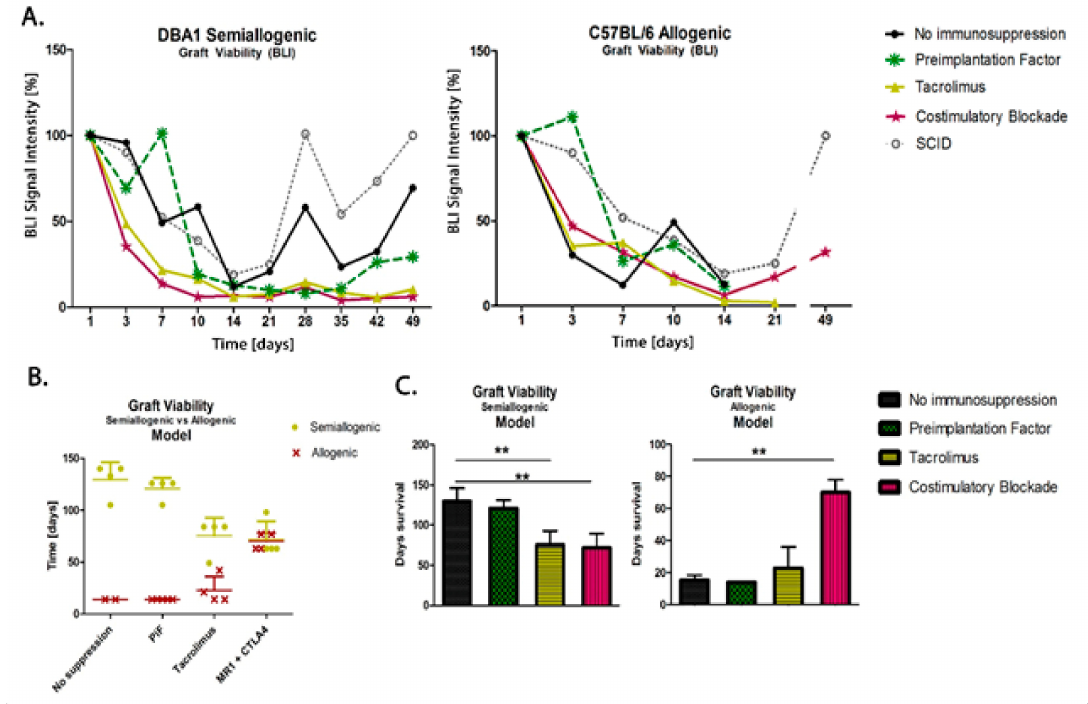
Figure 7. Comparison of graft survival in semiallogenic DBA1 and allogenic C57BL/6 mouse models: ( A ) Graphic presentation of GRP graft viability (presented as the proportion out of initial BLI as 100% of intensity signal) transplanted into healthy models in semiallogenic (left) and allogenic (right) combinations. ( B ) Graphic presentation of cellular graft viability in semiallogenic (yellow dots) and allogenic (red crosses) mouse models after performed GRP transplantation. The murine GRP graft survived well in semiallogenic mice even if no immunosuppression was applied. The graft survival in the allogenic model was the longest and comparable to the semiallogenic model after the co-stimulatory molecules blockade. ( C ) Bar graphics of graft survival in semiallogenic mouse model (right) as compared with different groups of immunosuppressive/immunomodulatory regimens (** p < 0.005). Unpaired Student’s t -test; data are presented as median, error bars: SD; the total number of biological replicates per group = 4–5. Abbreviations: BLI-bioluminescence imaging; GRP-glial-restricted progenitor